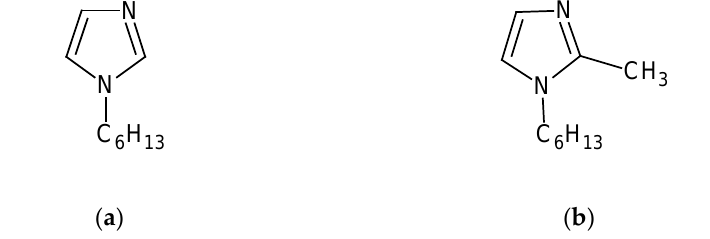
Figure 1. The chemical formula of 1-alkyl-imidazoles (carriers): ( a ) 1-hexylimidazole ( 1 ) b.p. 134–136 °C/12 mmHg; ( b ) 1-hexyl-2-methylimidazole ( 2 ) b.p. 130–131 °C/14 mmHg.